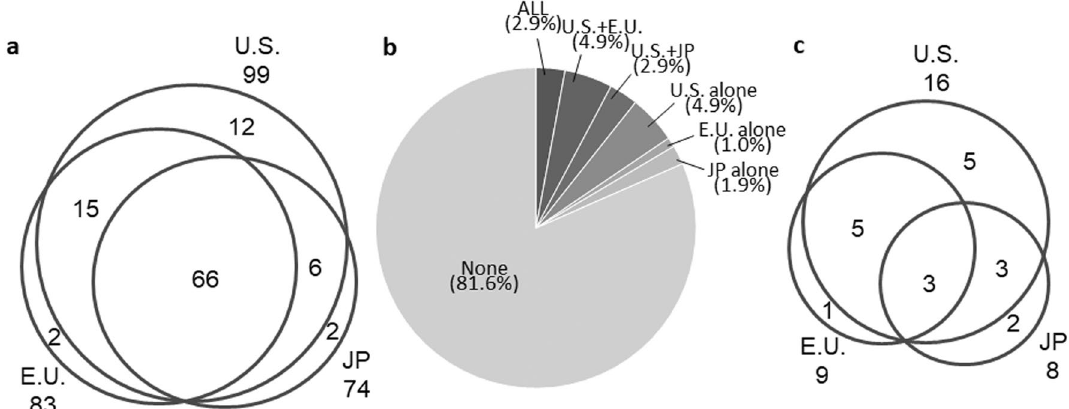
Figure 1. Approval status of molecular targeted antineoplastic drugs in the U.S., the E.U., or JP. a 103 drugs with adult indications. b Overview of pediatric indications. c 19 drugs with pediatric indications. U.S. United States; E.U European Union; JP Japan.